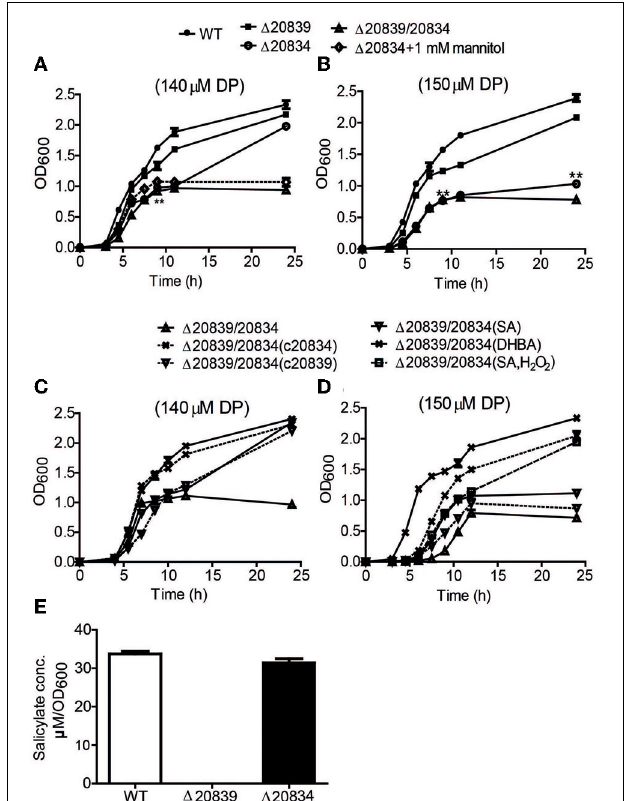
FIGURE 2 | Growth characteristics and SA production by WT strain and respective mutants. Bacteria were grown in 2.5% NaCl-HI broth supplemented with either 140 μ M DP (A,C) or 150 μ M DP (B,D) . In some growth assays bacterial deletion mutants were complemented with plasmids carrying respective genes. Depending upon experiments mannitol (1mM), SA (5 μ M), DHBA (5 μ M), or SA (5 μ M) with H 2 O 2 (10 μ M) was added along with DP. SA produced by wild type and mutants cultured in minimal media was also assessed (E) . OD 600 values at each time point are the means of two independent experiments done in triplicate. The error bars represent the standard errors. ** P < 0 . 01.